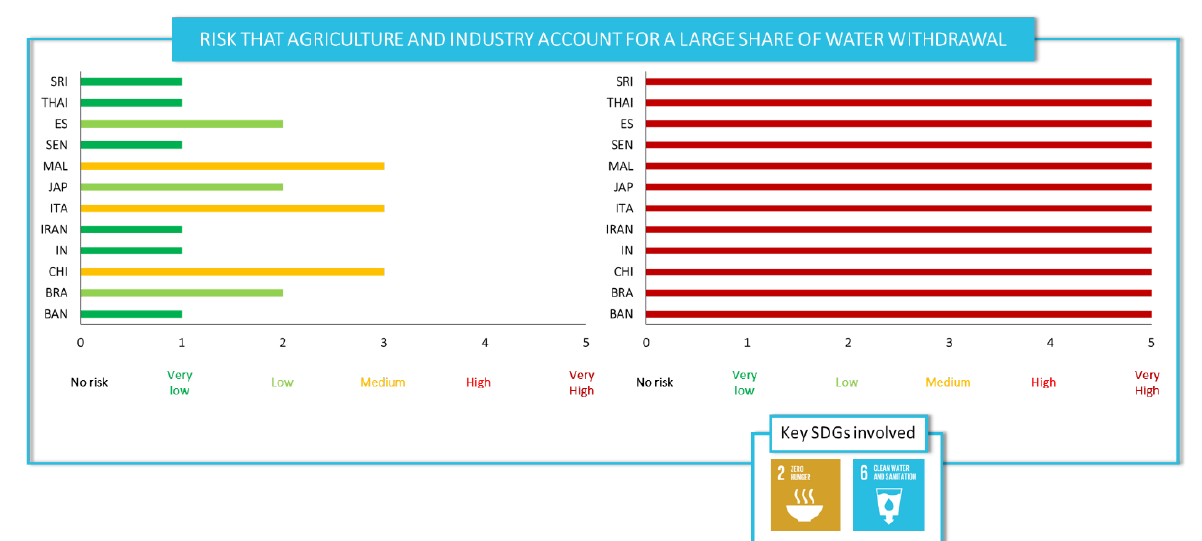
Figure 10. Risk that agriculture and industry account for a large share of water withdrawal [74].